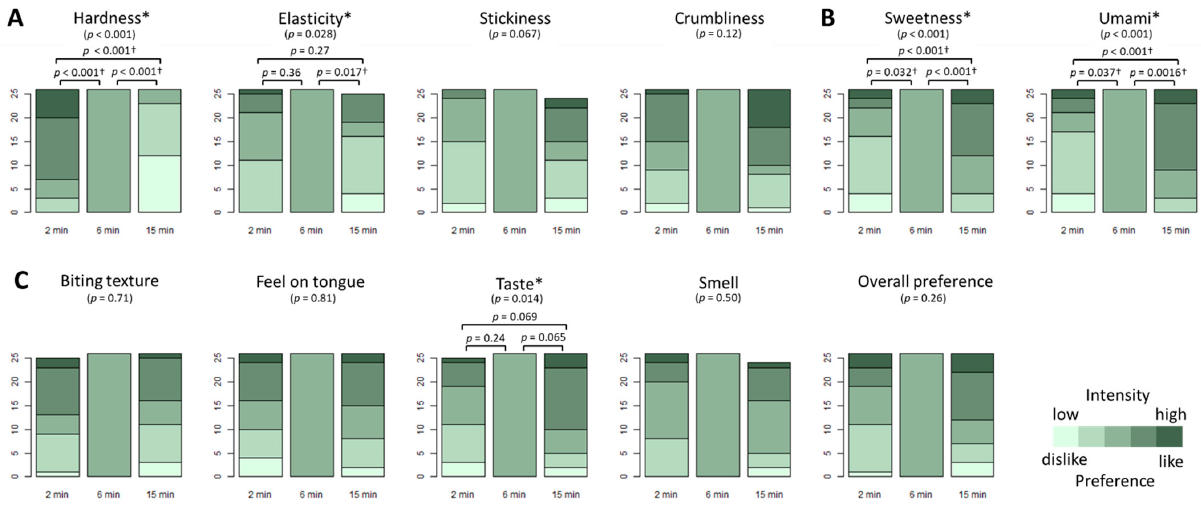
Figure 1. Sensory characteristics of edamame beans boiled for 2, 6, and 15 min. Objective evaluations for physical characteristics ( A ) and taste components ( B ) and subjective evaluation for individual preferences ( C ) by 26 panelists are shown by cumulative bar plots. Asterisks (*) indicate the evaluation components where significant differences among processing conditions were observed (Friedman test, p < 0.05); for these components, pairwise comparisons between any two of the three combinations were performed, and the combinations with significant differences are marked by daggers (†) (Wilcoxon signed-rank test with Holm correction at α = 0.05).